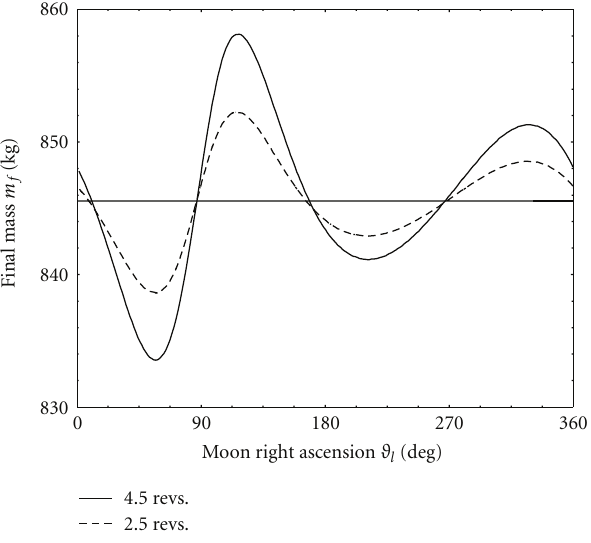
Figure 10: Final mass as a function of the Moon initial position for 2.5- and 4.5-revolution 8 N transfers (Sun